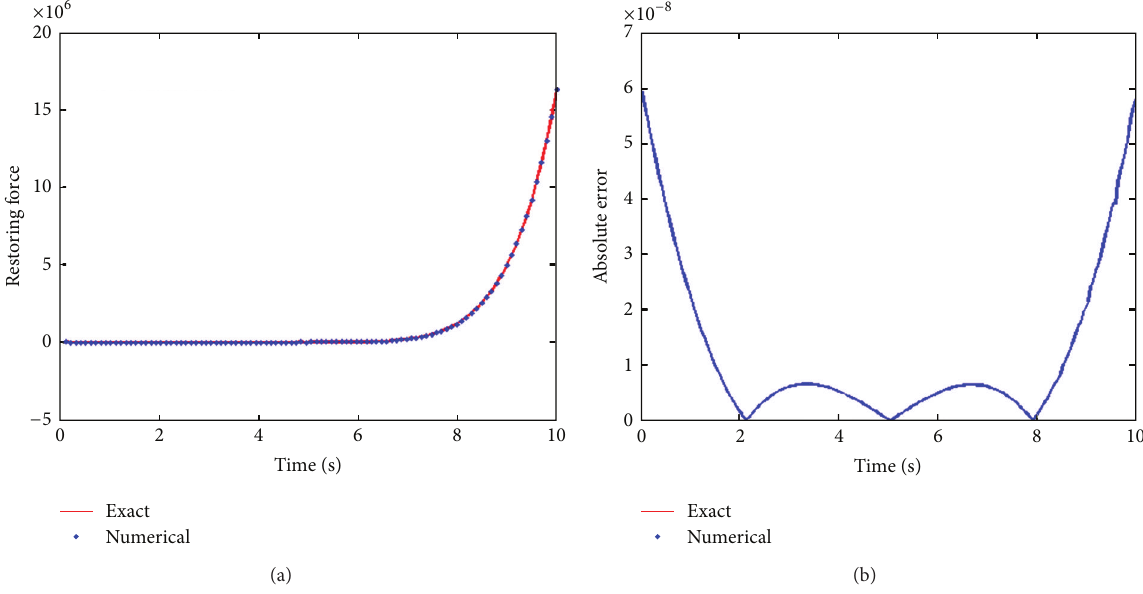
Figure 8: For Example 2, (a) comparing exact solution and numerical one for restoring force with 𝑇 0 = 120 and 𝑚 = 100 under 10 seconds and (b) displaying the estimated error of restoring